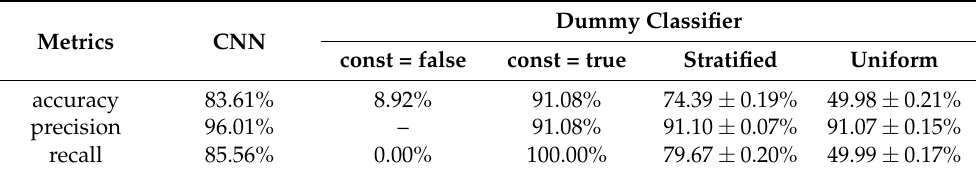
Table 7. Performance comparison between CNN-based and Scikit Dummy Classifier detectors for an unlaminated color copy per-frame detection